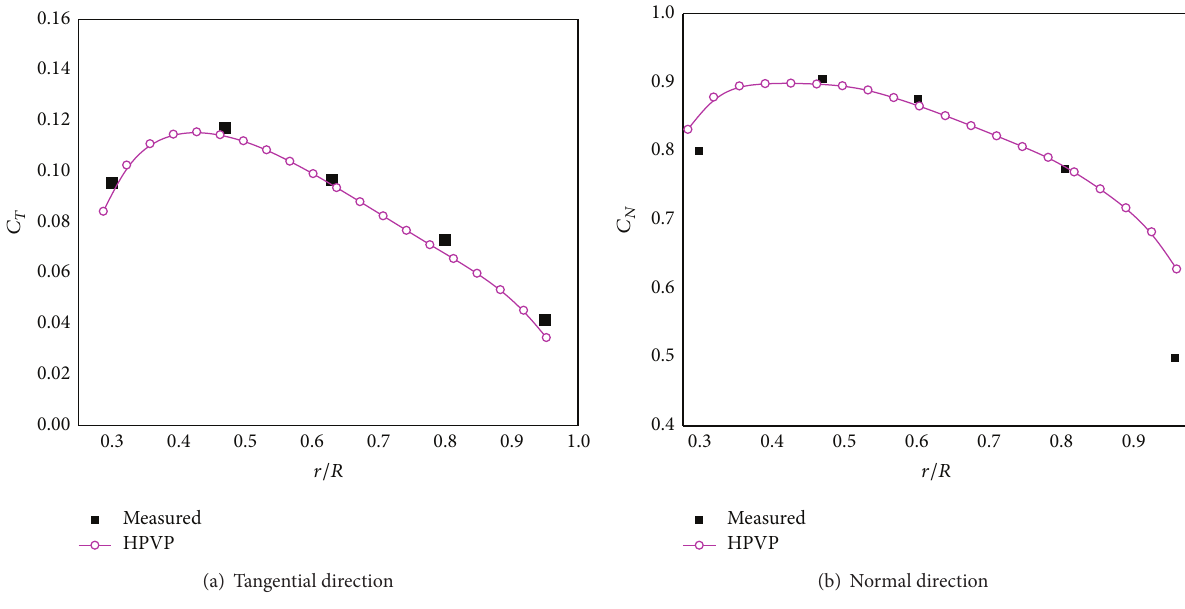
Figure 7: Tangential and normal force coefficients comparisons.